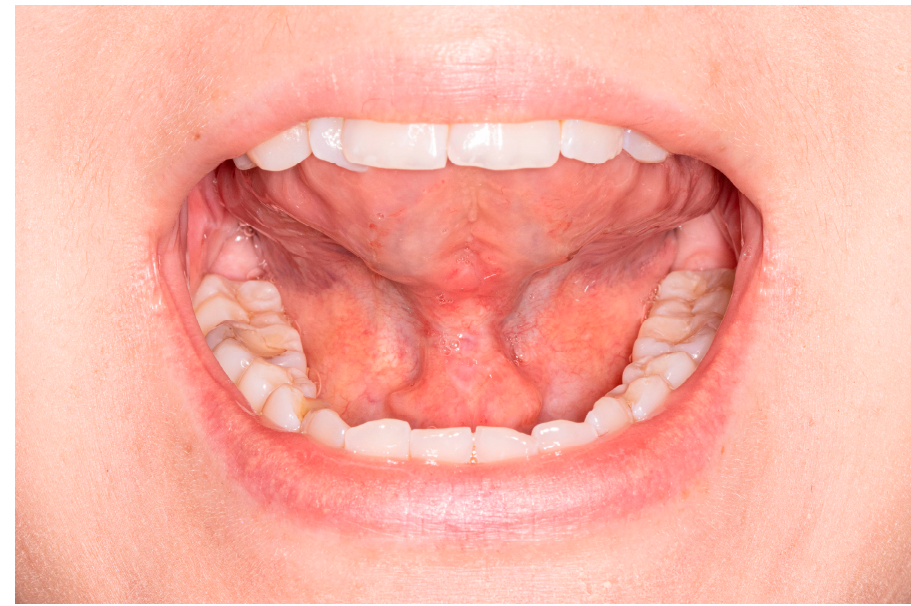
Figure 6. Final result after 1 month; the whole tongue reaches palate during LPS (TRMR-LPS > 60%).